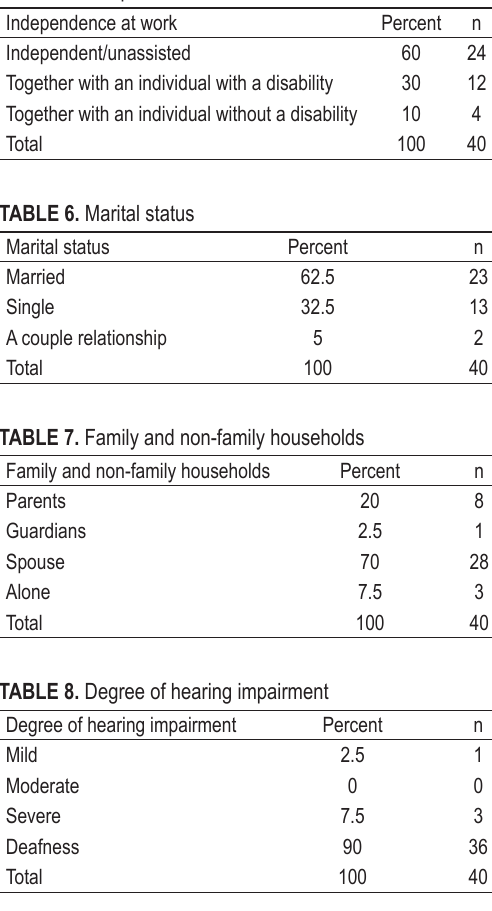
TABLE 5. Independence at work